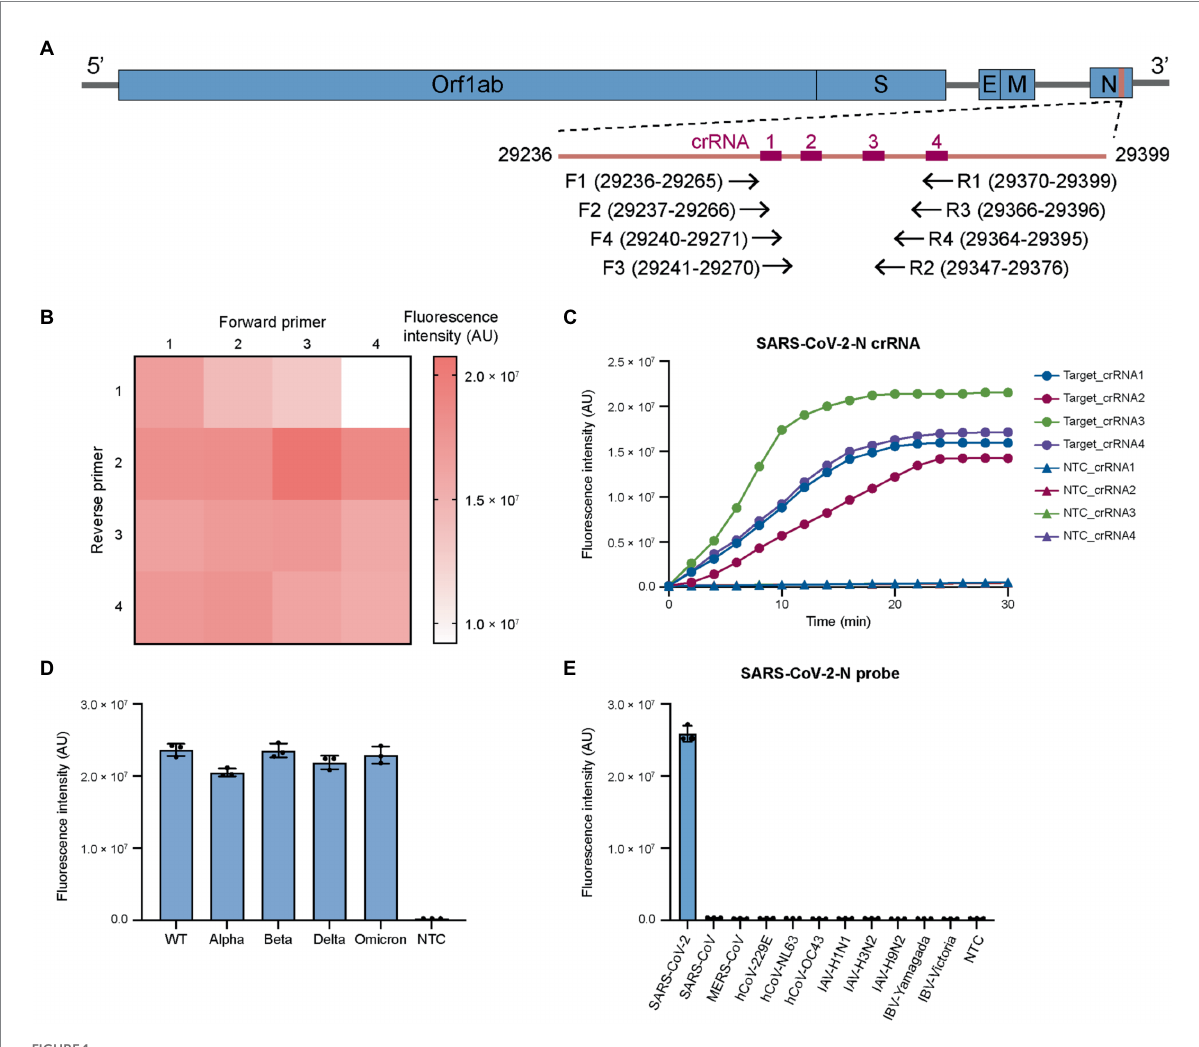
FIGURE 1 Screening RT-RPA primers and CRISPR crRNAs for coronaviruses and influenza viruses. (A) Genomic structure of SARS-CoV-2 showing the target sites in N gene for RT-RPA primers and Cas12a crRNAs. The primers and crRNAs are designed to target conserved region. (B) Screening RT-RPA primers for SARS-CoV-2 detection. (C) Screening crRNAs for SARS-CoV-2 detection. (D) The universal detection for SARS-CoV-2 variants. (E) The specificity of SARS-CoV-2 detection. For each virus, the viral copies are in the range of 10 6 –10 7 per reaction. The RT-RPA primers are SARSCoV2- N-RPA-F3/SARSCoV2-N-RPA-R2 and crRNA is SARSCoV2-N-crRNA3. WT, wild-type. Target, SARS-CoV-2 IVT N gene RNA (1 nM). NTC, non- template control. The data from three biological replicates are shown as mean ± standard deviation